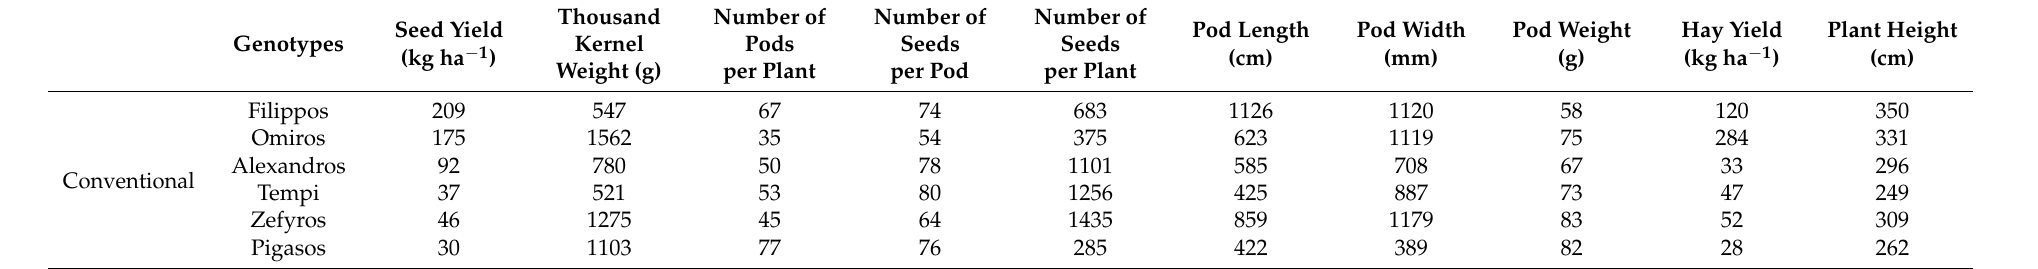
Table 2. Trait stability index across genotypes for the two farming systems: seed yield (kg ha − 1 ), thousand kernel weight (g), number of pods per plant, number of seeds per pod, number of seeds per plant, pod length (cm), pod width (mm), (mean) pod weight (g), hay weight (kg ha − 1 ), plant height